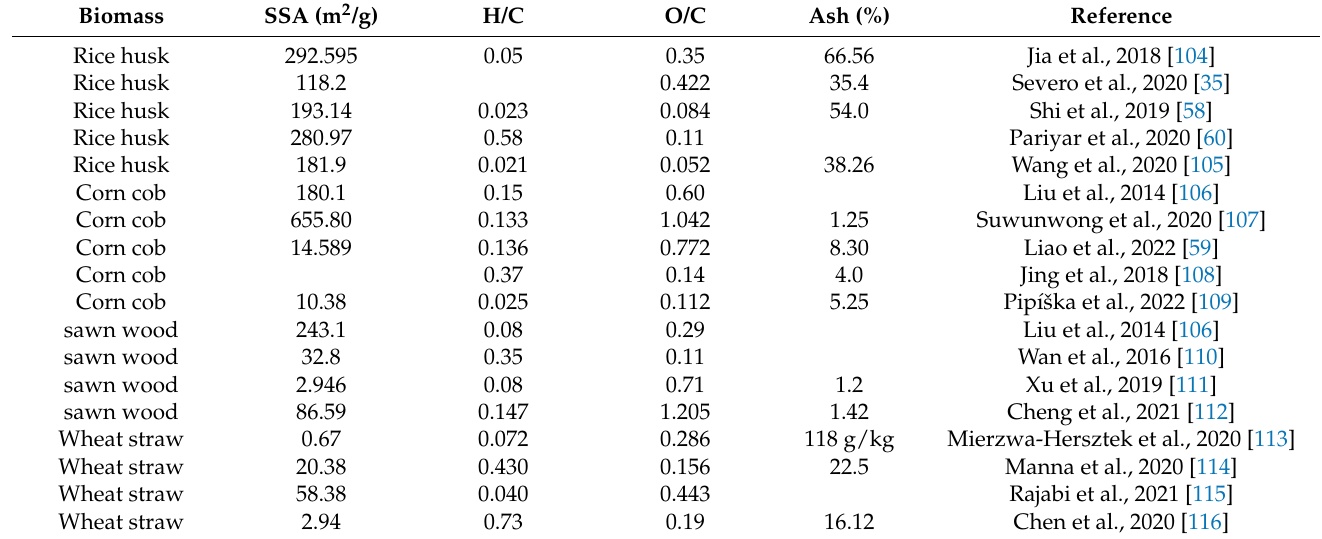
Table 3. Physical and chemical properties of RHB, corncob biochar, and pomelo peel